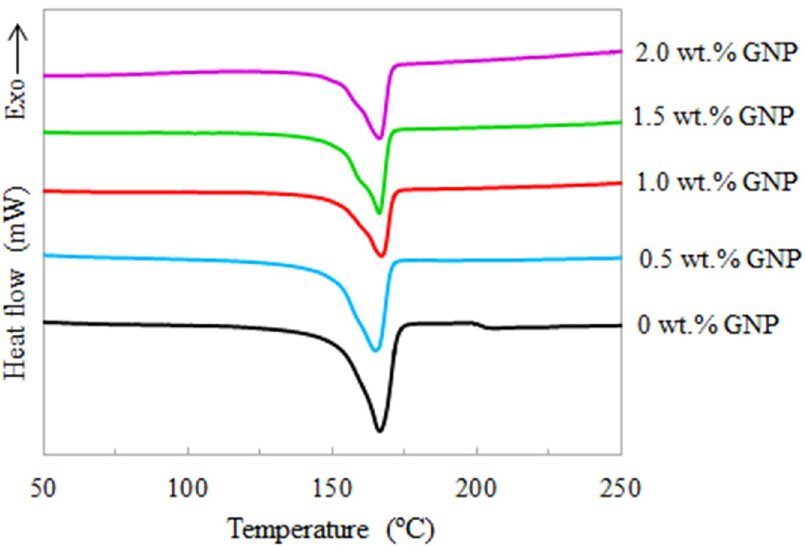
Fig 6. DSC thermograms of the neat TPNR sample and TPNR/GNP with different nanofiller weight